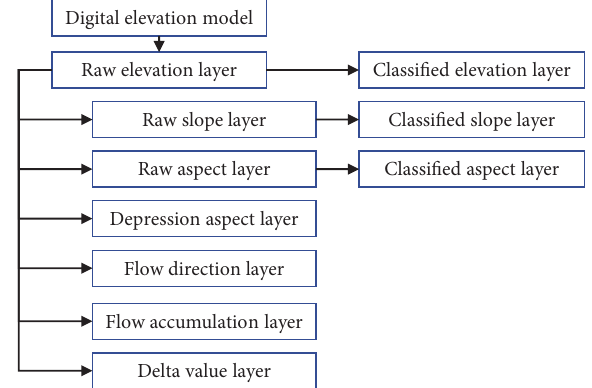
Figure 2: Proposed multilayer GIS database for natural resources by Khalid.